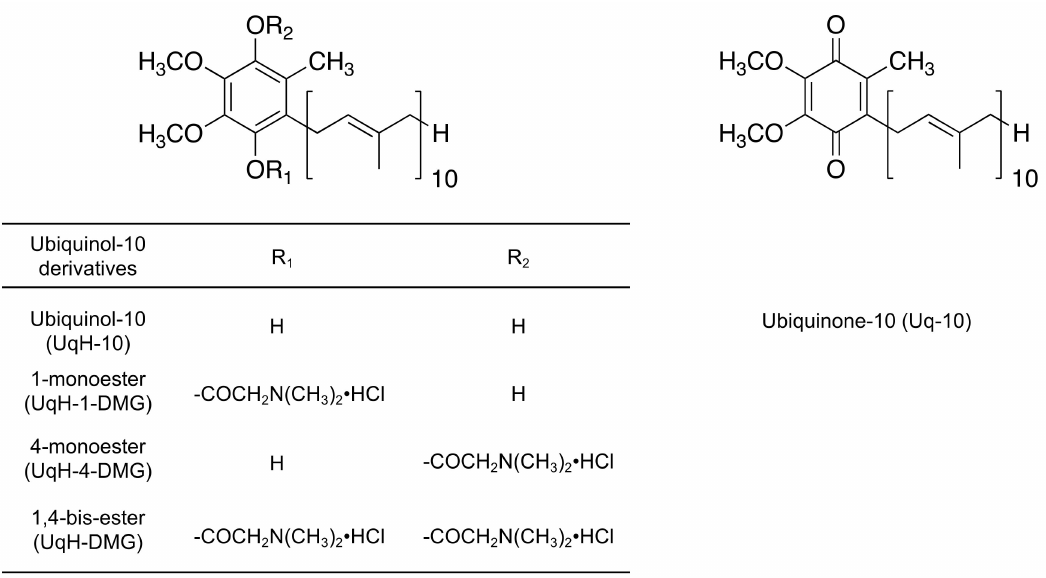
Figure 1. Chemical structures of Ubiquinol-10 derivatives and